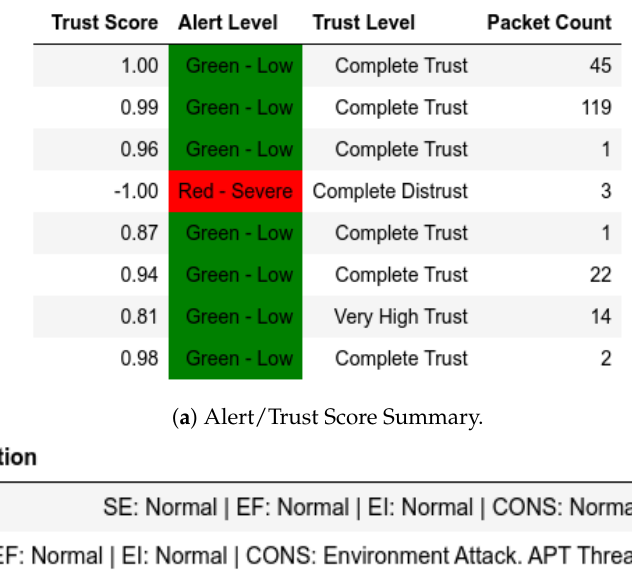
Figure 11. Server: EPM external test- H m in send-fake-command attack capture.